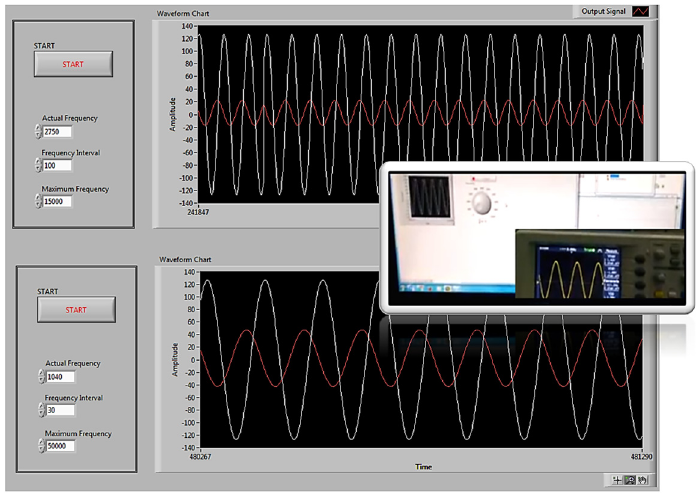
Figure 4. Tests of the functioning of the system in real time.